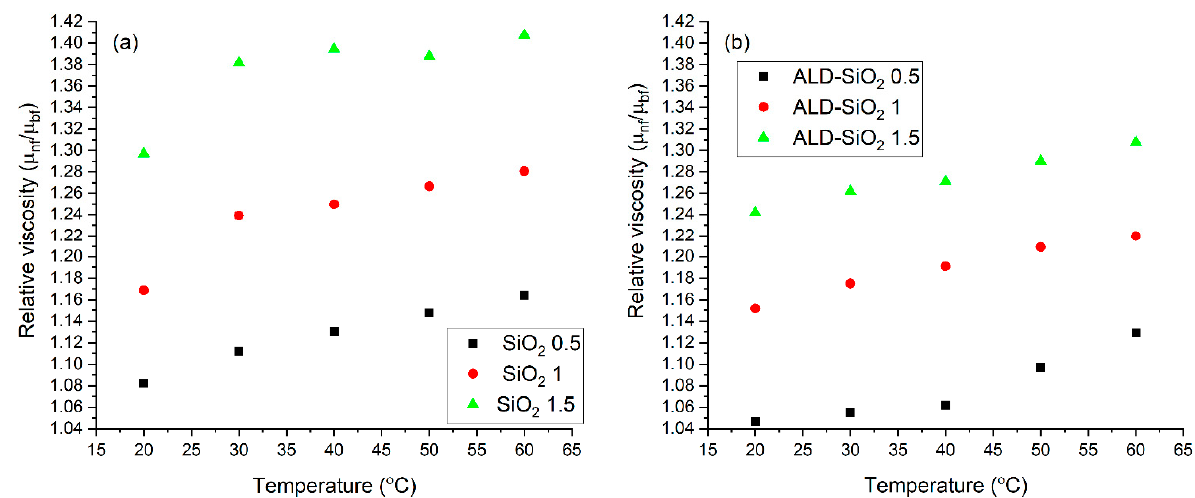
Figure 7. The relative viscosity of the SiO 2 ( a ) and composite nanofluids ( b ) as a function of tem- perature.